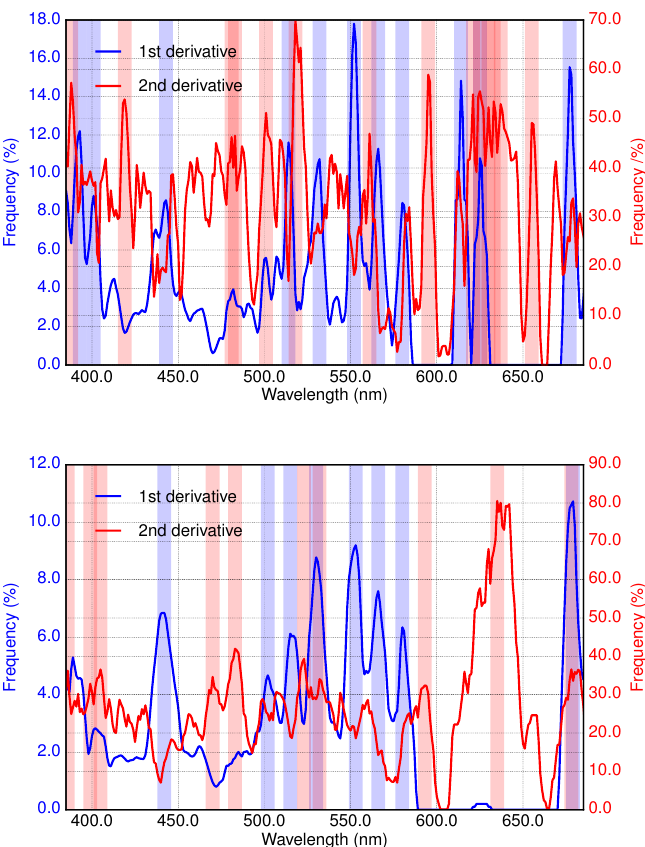
Figure 7. Spectral distribution of the frequency where the first and the second derivatives of simulated R rs equal zero for filter smoothing windows of 5 nm (top) and 10 nm (bottom). The bands of highest frequencies of the first and the second derivatives are highlighted in blue and red, respectively.